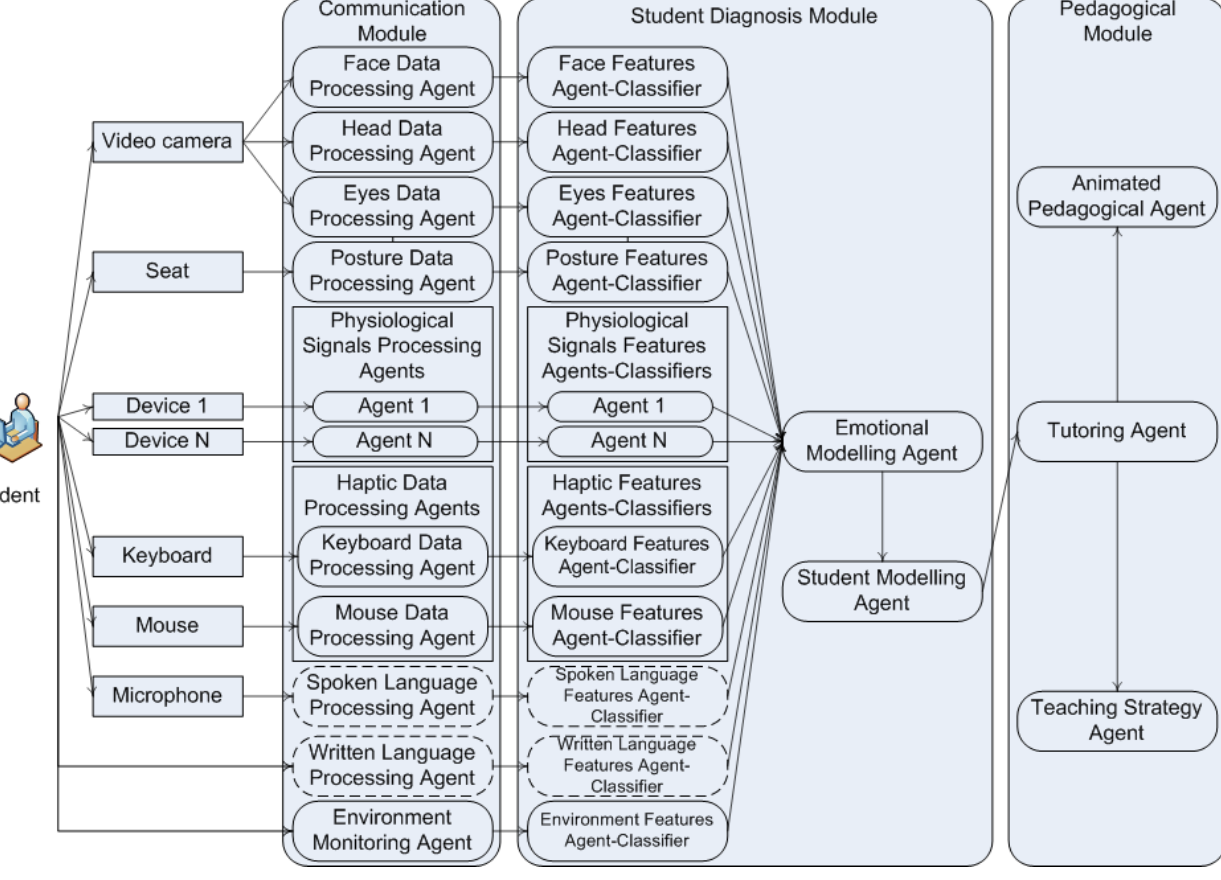
Fig.2. The set of agents for the modelling of student’s emotions in intelligent tutoring